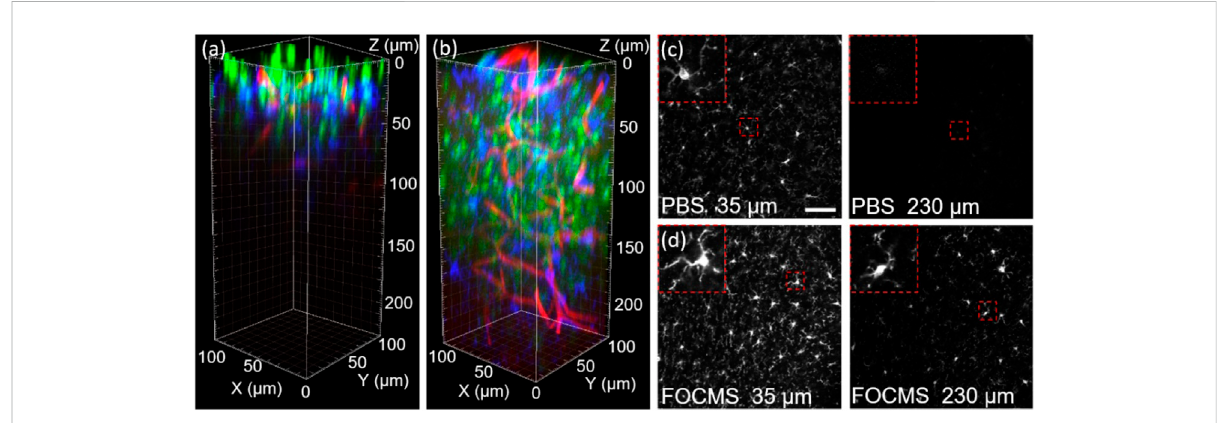
FIGURE 3 Fluorescence imaging of brain tissue (A) before and (B) after optical clearing. Green: nucleus, blue: glia cell, red: blood vessel. Comparison of glia cell imaging at the depth of 35 μ m and 230 μ m (C) before and (D) after clearing, respectively. Scalebar: 50 μ m.